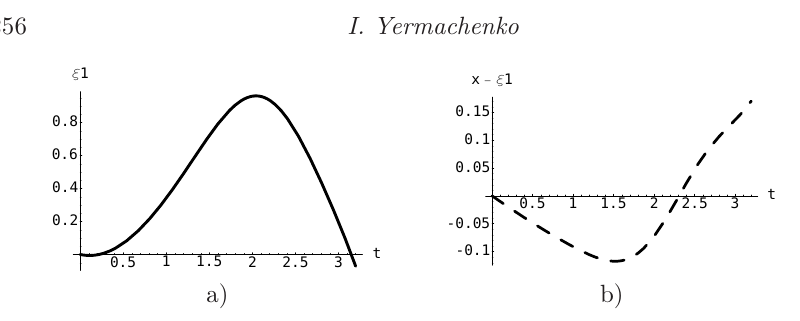
Figure 8. 1 -type solution of the problem (3.15).